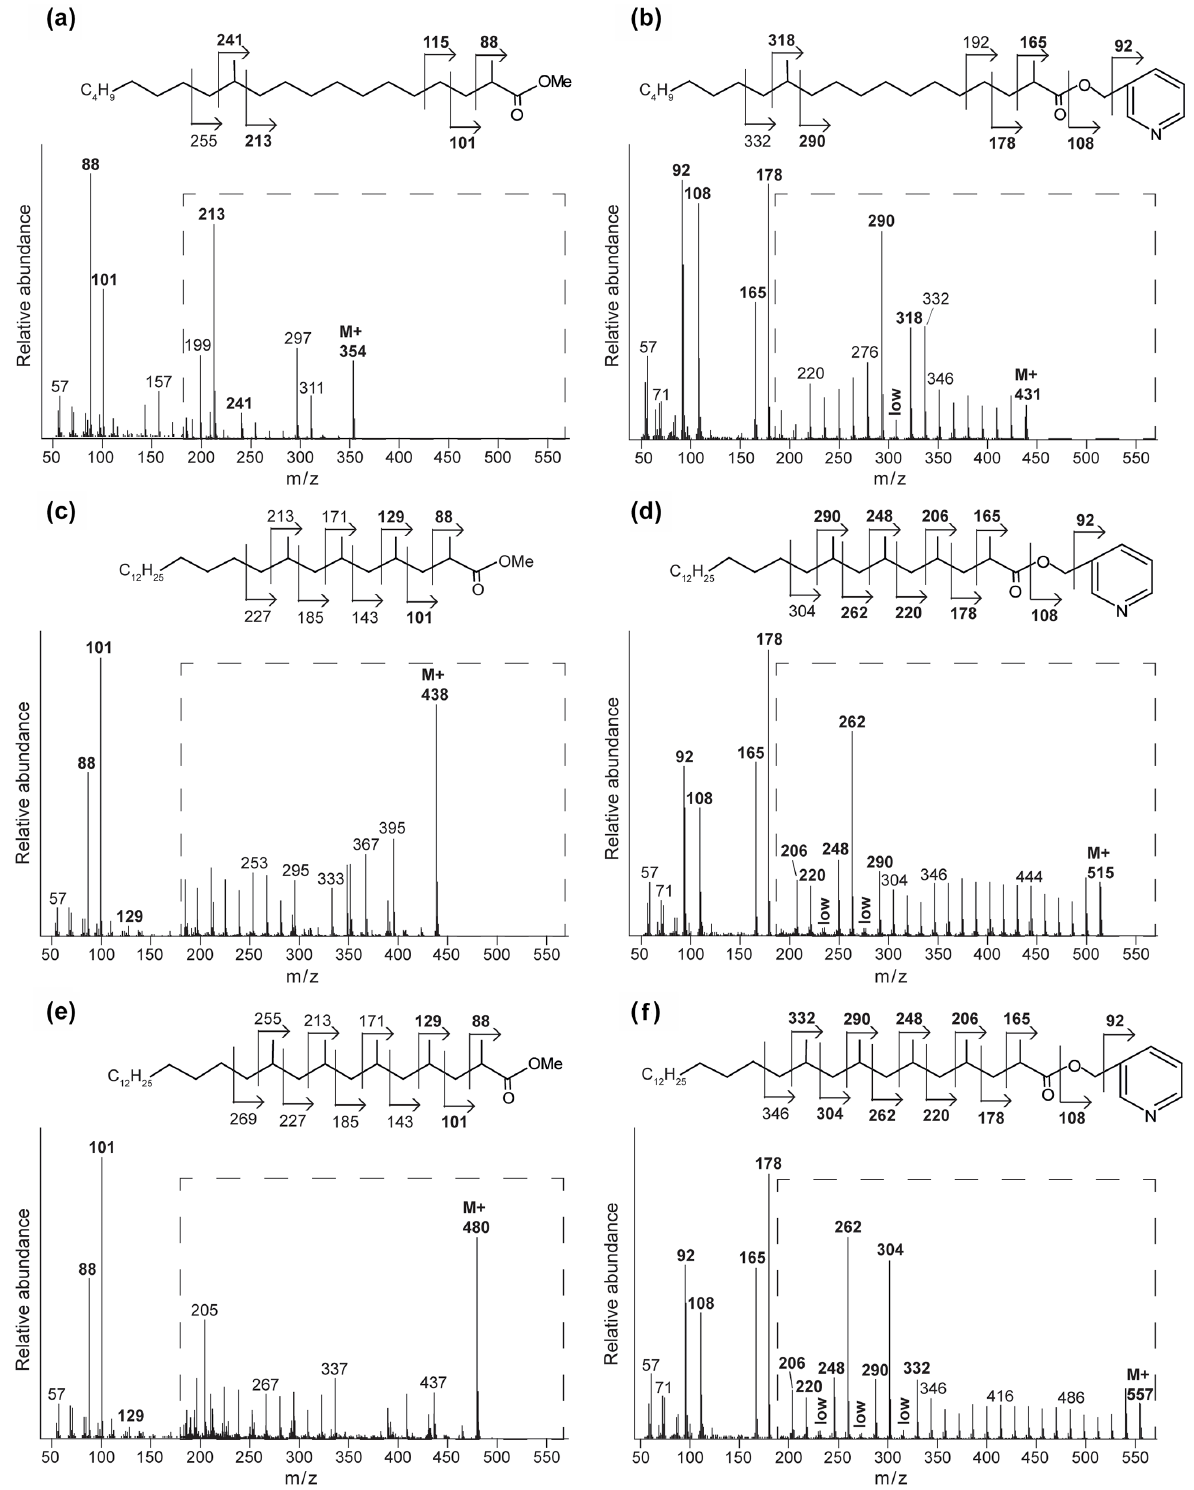
Figure 3. Mass spectra of the methyl-ester-derivatized (a, c, e) and picolinyl-ester-derivatized (b, d, f) MAs of the Censo 0m soil sample, with proposed molecular structures and fragmentation patterns. 2,12-Dimethyl-eicosanoic acid (C 22 2,12-Me MA) (a, b) , 2,4,6,8-tetramethyl- tetracosanoic acid (C 28 2,4,6,8-Me MA) (c, d) , and 2,4,6,8,10-pentamethyl-hexacosanoic acid (C 31 2,4,6,8,10-Me MA) (e, f) . The dashed boxes show a 10 times exaggerated view into the indicated area of the mass